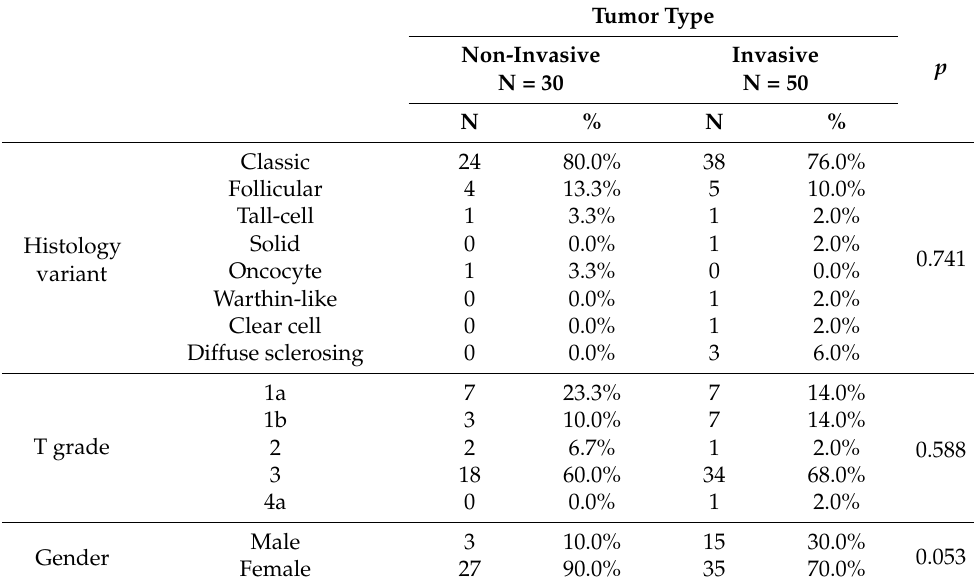
Table 1. Differences in histology type, T status, and patient gender distribution between non-invasive and invasive tumor types: Fisher–Freeman–Halton’s exact